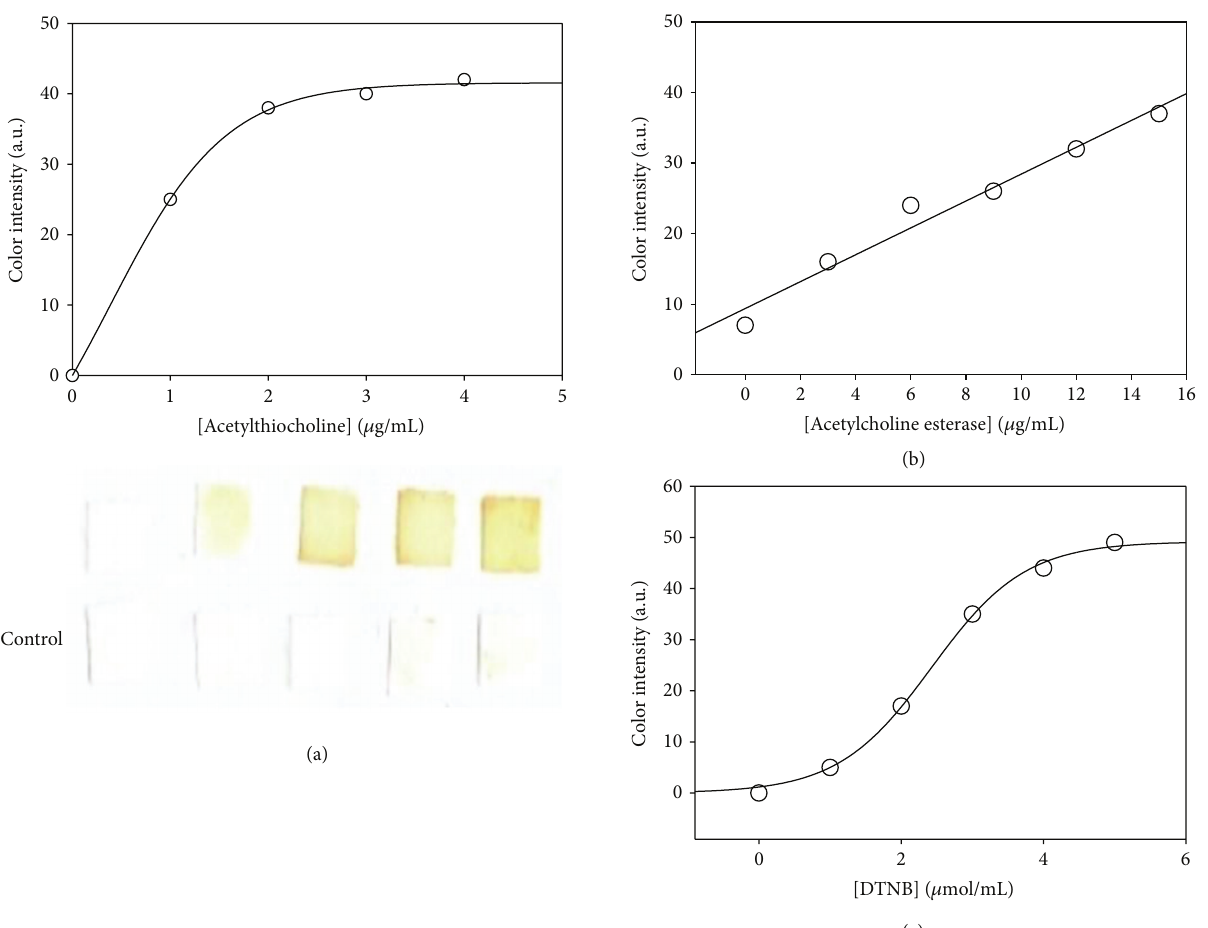
Figure 3: The response of biosensor (a) at different substrate, (b) enzyme, or (c) Ellman’s reagent concentrations. In each experiment, ATCh, AChE, and DTNB were mixed and adsorbed into paper matrix. Their fixed concentrations were AChE 12U/mL, DTNB 4 𝜇 g/mL, and ATChI 4 𝜇 g/mL. The lower panel in (a) shows pictures of paper sensor; upper row is performed with sensor mixture and lower row with control mixture (lacking the enzyme